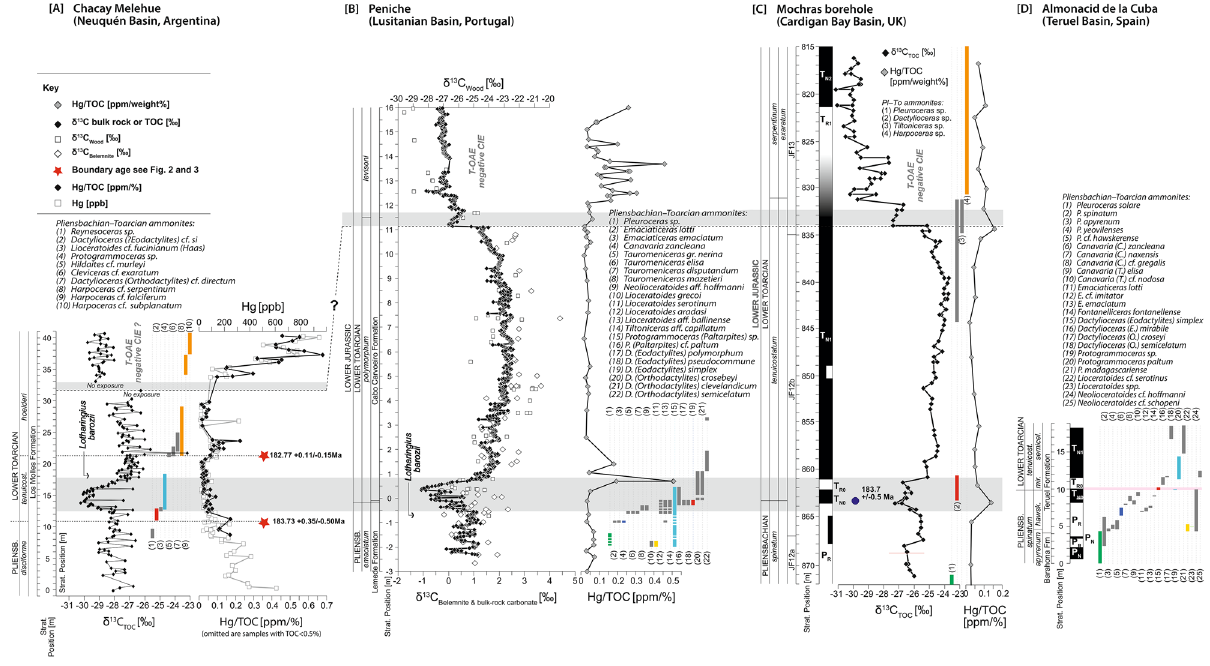
Figure 4. Comparison of Hg/TOC, [Hg], carbon isotopes, magnetostratigraphy and ammonite biostratigraphy from Chacay Melehue (this study), Peniche (Lusitanian Basin, Portugal) 2,6 , the Mochras Borehole including astronomical age of 183.70 ± 0.50 60 (Cardigan Bay Basin, UK) 45,58,60,61 , and the Almonacid de la Cuba section (Spain) 62,63 . Grey bands indicate the Pliensbachian–Toarcian boundary and the Toarcian carbon-isotope excursion. Key ages calculated in this study are also indicated by red